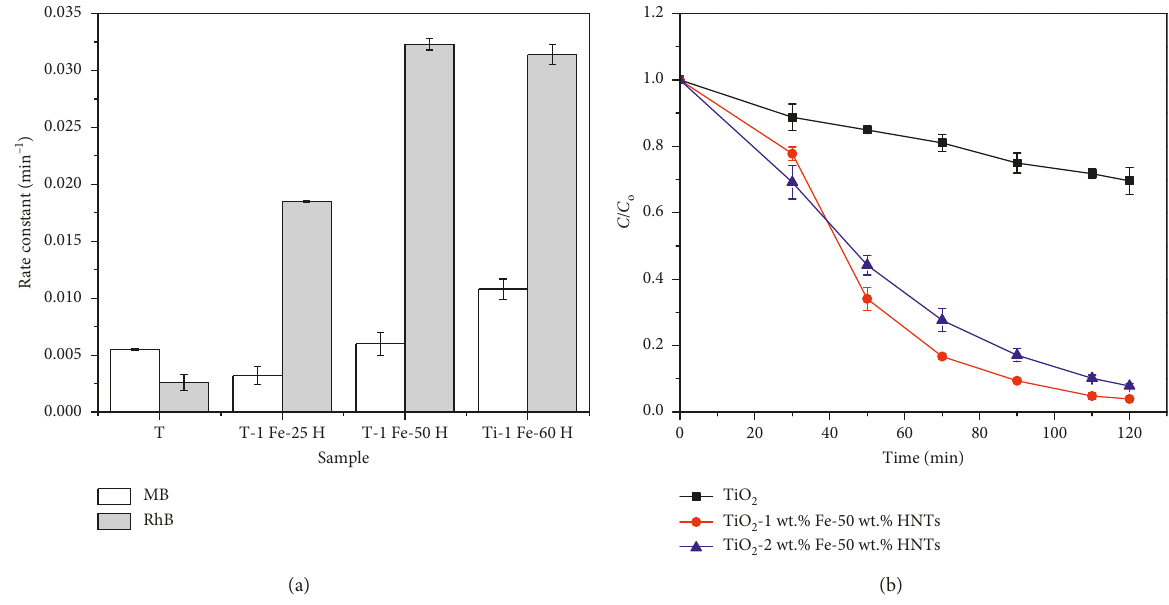
Figure 3: (a) Pseudo-first-order rate constants for photodegradation of rhodamine B (RhB) and methylene blue (MB). (b) Effect of Fe wt.% on the photodegradation efficiency of TiO 2 -Fe-HNT composite (rhodamine B).